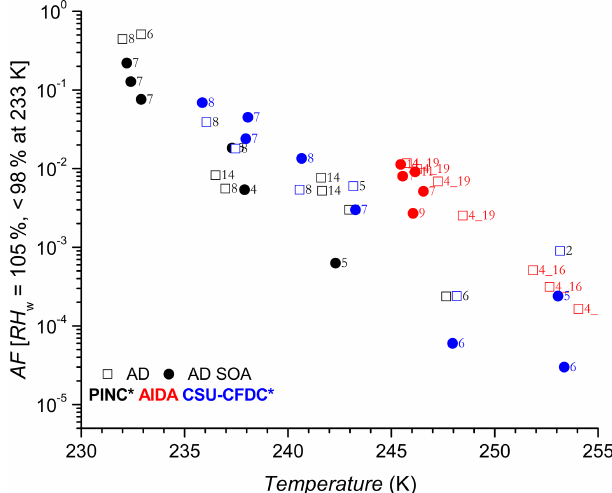
Figure 4. Activated fraction ( AF ) as a function of temperature for Asian dust (AD, open squares) and AD coated with SOA (AD SOA, filled circles). Numbers next to data points refer to experiment num- ber. Coating thicknesses are shown in Table 1. The asterisk ( ∗ ) de- notes that the PINC and CSU-CFDC data have been increased by a factor of 3 (see text Sect. 4 for details). Error bars for AF of 10% (CSU-CFDC), 14% (PINC) and 28% (AIDA) when plotted are hardly visible (not shown).